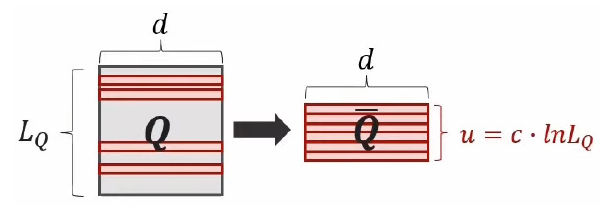
Figure 2. Calculation diagram of Q